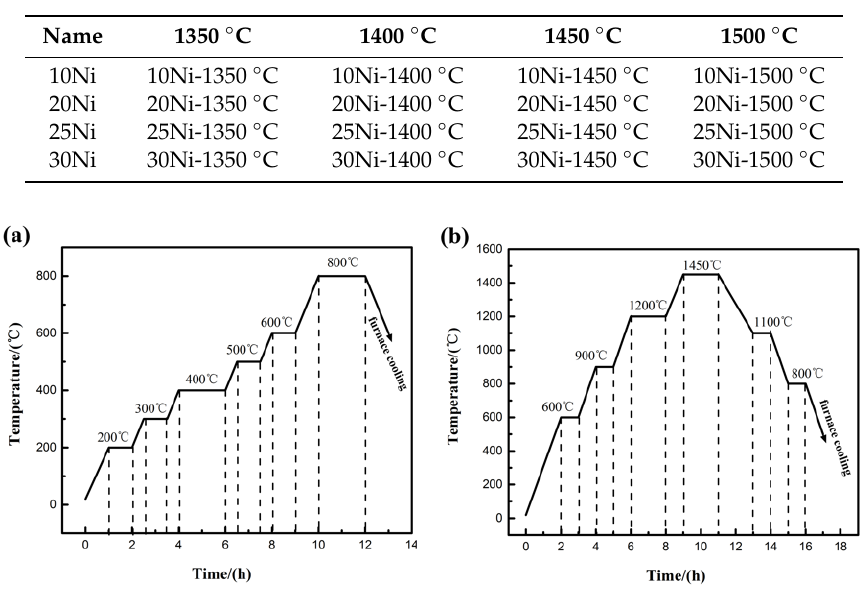
Figure 2. ( a ) De-binding curve and ( b ) sintering process curve of Ti(C,N)-based cermets.